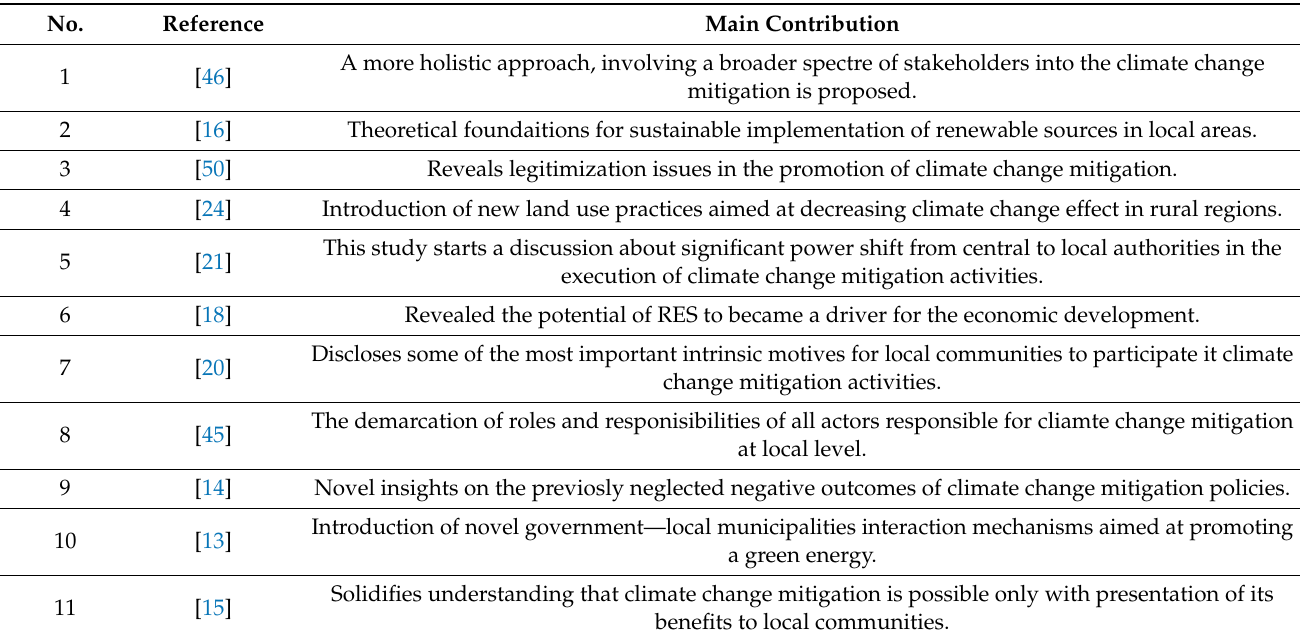
Table 1. Studies on climate change mitigation at the local